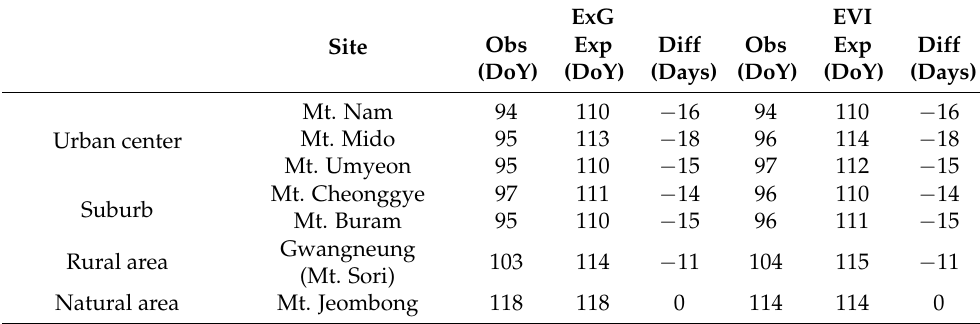
Table 4. Green-up dates estimated by two different criteria, ExG and EVI, and the difference between observed and expected green-up dates from ExG and EVI. Obs : observed, Exp : expected, Diff : difference.